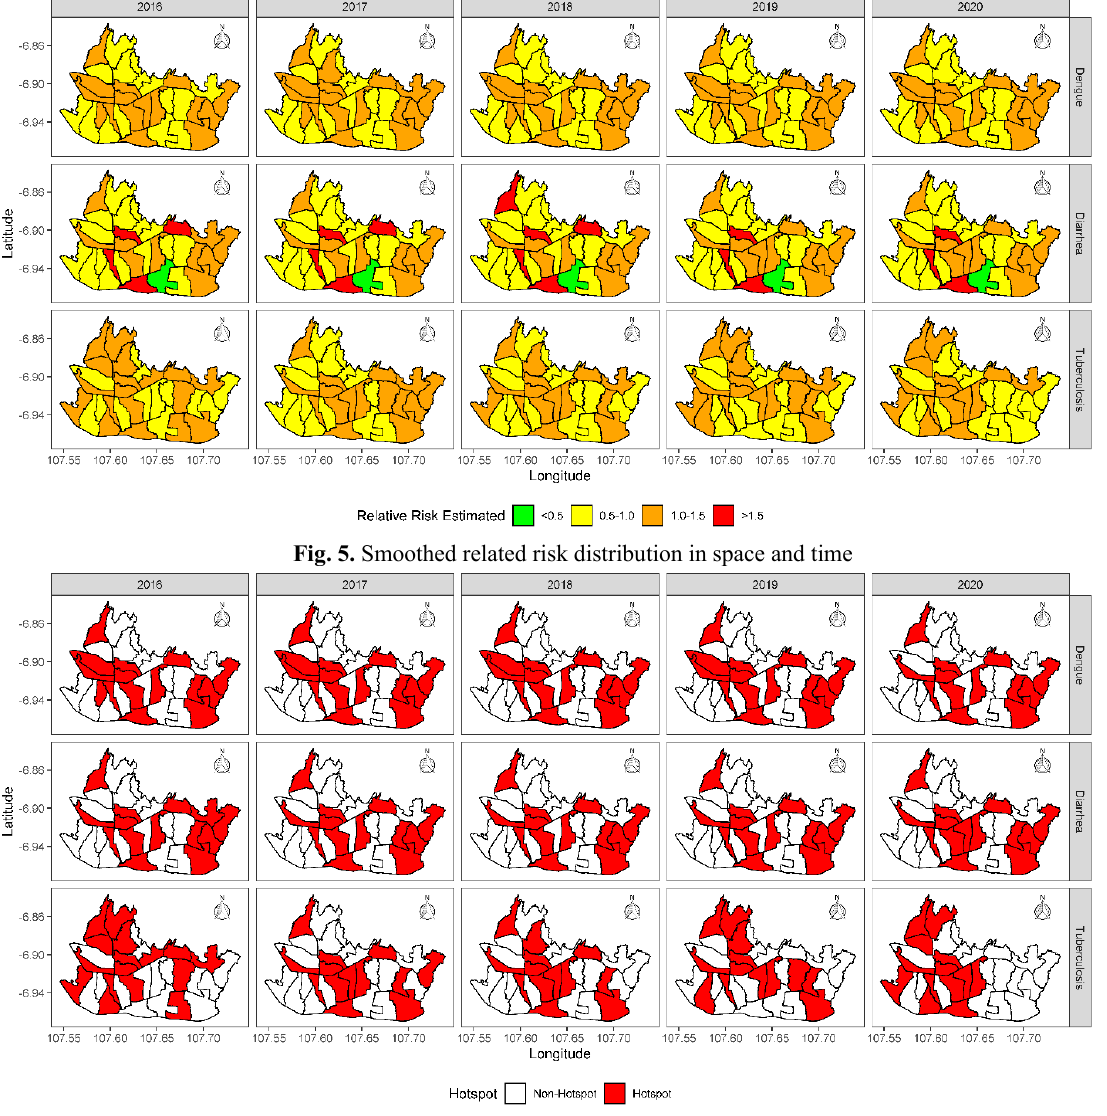
Fig. 6. Spatiotemporal distribution of hotspot for three infectious